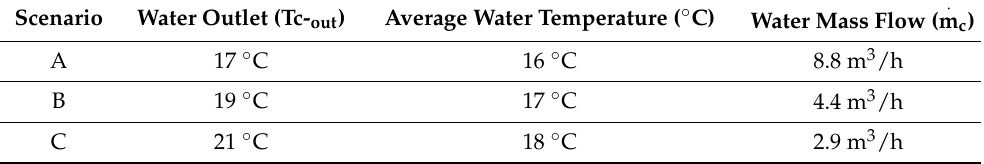
Table 3. Scenarios for water